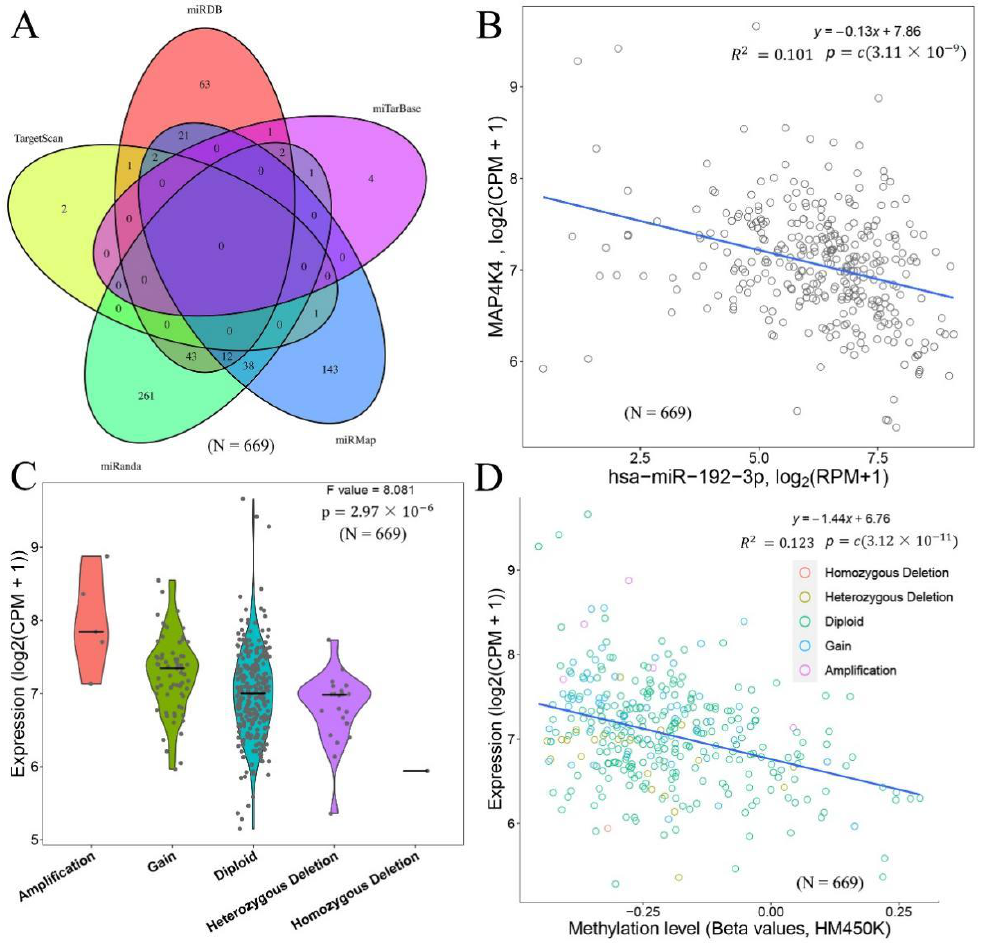
Figure 3. miRNA regulation relationship and CNV correlation analysis of MAP4K4. ( A ) Venn diagram of the predicted miRNA regulatory relationship with MAP4K4 in 5 miRNA databases: miRDB, miTarBase, miRMap, miRanda, and TargetScan; ( B ) correlation diagram between MAP4K4 and has-miR-192-3p; ( C ) the expression of MAP4K4 in various types of CNVs in the cancer sample; ( D ) scatter plot and correlation of MAP4K4 expression in cancer samples and the β value of the corresponding methylation level. Circles with different colors represents different CNV classifications. Infinium methylation assay, a probe-based methylation profile, is used for the methylation profile. N represents the sample size.